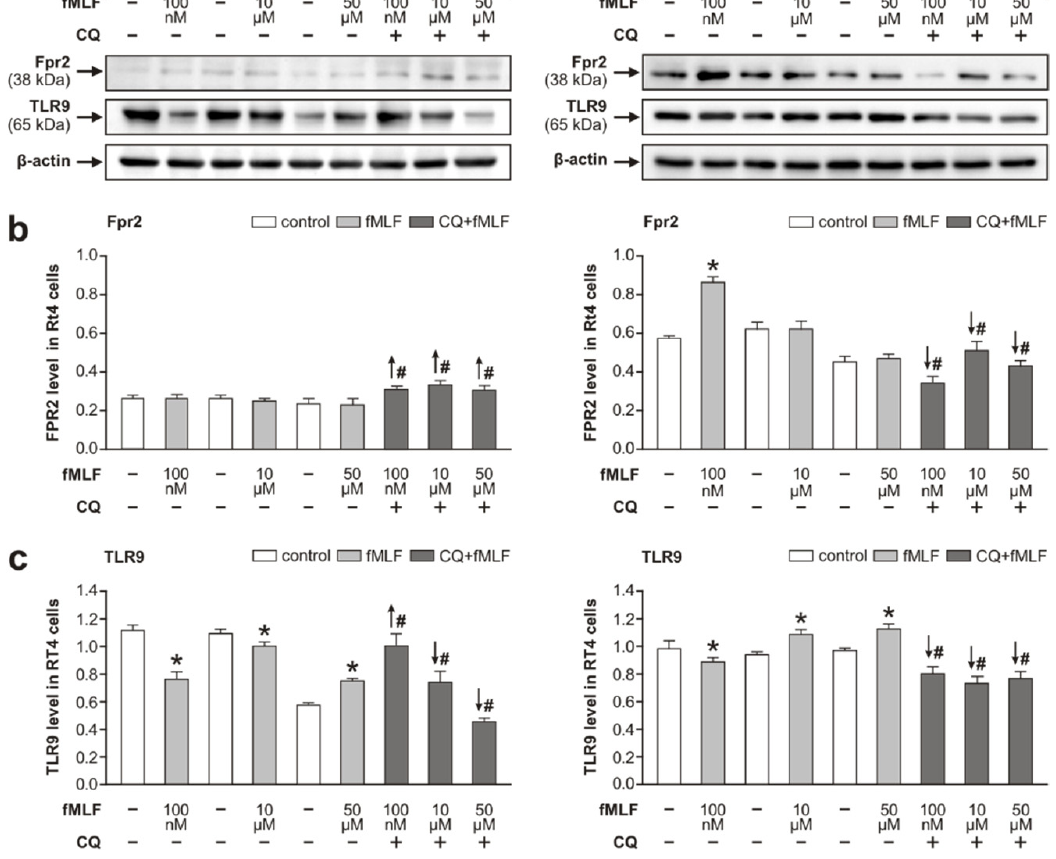
Figure 1. Effect of N -formyl-methionyl-leucyl-phenylalanine (fMLF) stimulation on the levels of Fpr2 and TLR9 in RT4 cells. Protein levels of Fpr2 and TLR9 in RT4-D6P2T cells treated with different concentrations of fMLF (100 nM, 10 µ M, and 50 µ M) for 1 and 6 h and pretreatment with CQ (1 µ M) were analyzed using Western blots. Panel ( a ) shows representative Western blots of TLR9, Fpr2, and β -actin. Results of densitometric measurements of bands from triplicate Western blot analysis normalized to the housekeeping protein β -actin are depicted in the graphs in panels ( b , c ). Results are shown as means ± SEM, * p < 0.05 compared to control, # p < 0.05 compared to stimulation with the relevant fMLF concentration without 1 µ M CQ, the up and down arrows indicate increased and decreased levels, respectively.